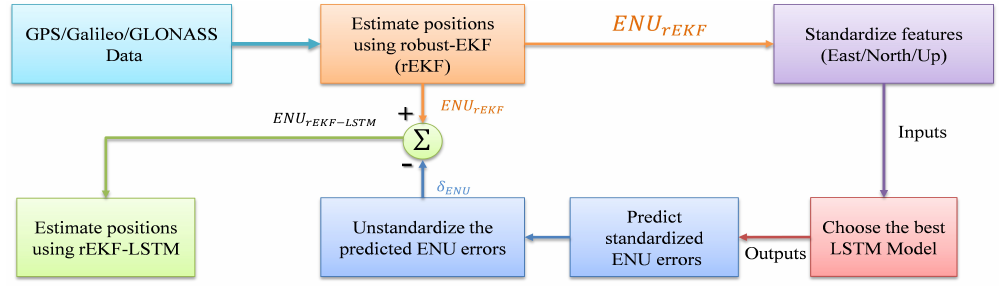
Figure 12. rEKF-LSTM Prediction